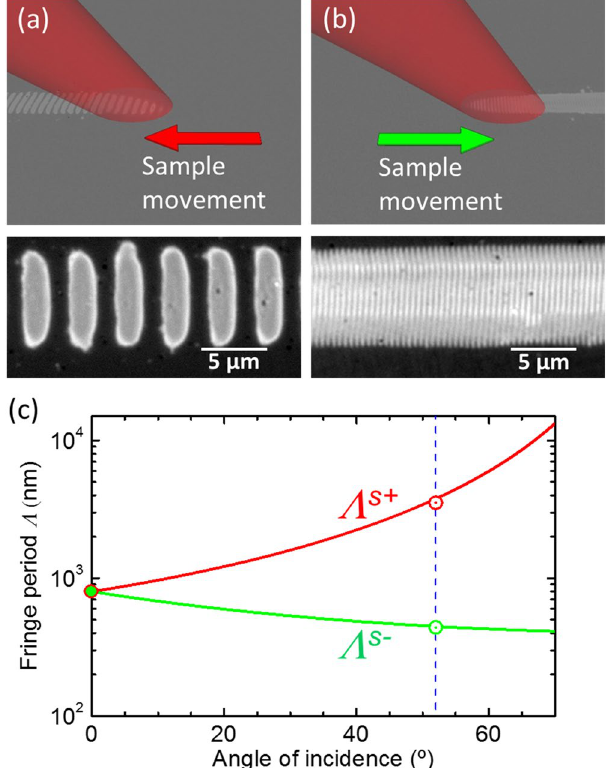
Figure 3. ( a , b ) Sketches of the strategies to preferentially write ( a ) Λ s + or ( b ) Λ s − LIPSS based on selecting the scan direction accompanied by optical micrographs of the written structures. Experimental parameters: θ = 52° , F = 145 mJ / cm 2 , v = 200 µ m / s ( c ) Calculation of the fringe periods Λ s + and Λ s − obtainable for a single laser wavelength ( λ = 800 nm ) as a function of angle of incidence. The symbols correspond to the experimental values obtained at θ = 0° and 52°